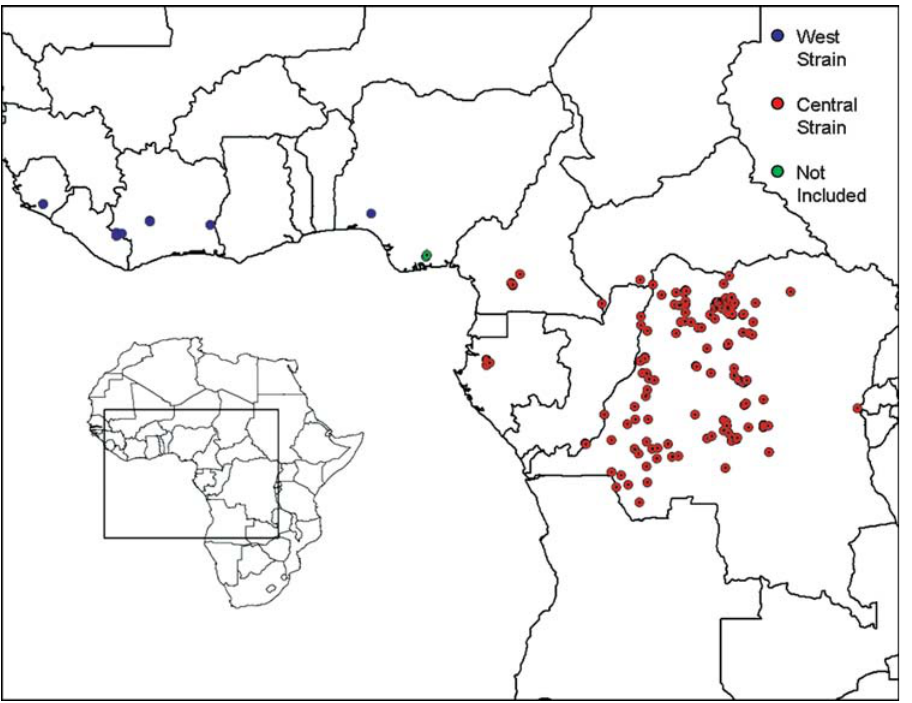
Figure 1. Occurrence locations of human monkeypox. Circles show partitioning of the 156 point occurrences into Central African (red), West Africa (blue), and unclassified (green) monkeypox genotypes.